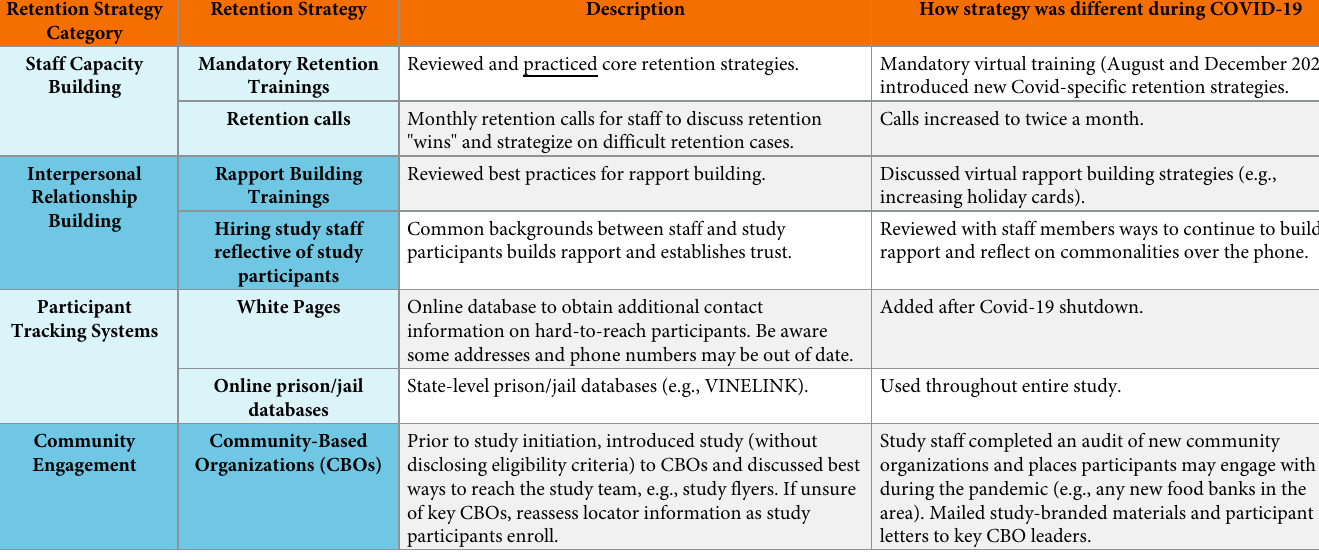
Table 1. Retention strategies and changes during COVID-19 for STUDY STAFF